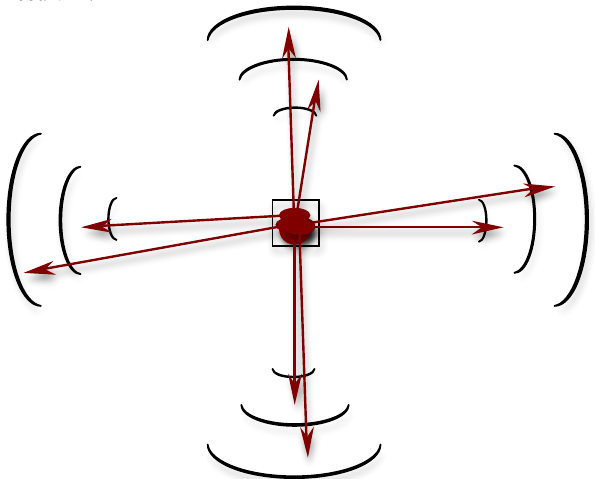
Figure 7: A bull’s eye interface for long and short gestures The surprising result regarding long and short SSGG